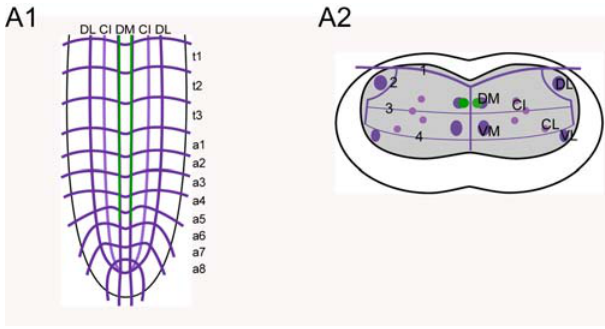
Figure 6. Morphology of eclosion hormone neurons. Mapping of eh - GAL4xUAS-cd8.gfp expressing neurons in whole-mount preparations of the thoracic and abdominal neuromeres of L3 larva in the Fas2 landmark system. A1) Idealized dorsal scheme. A2) Idealized transverse scheme.